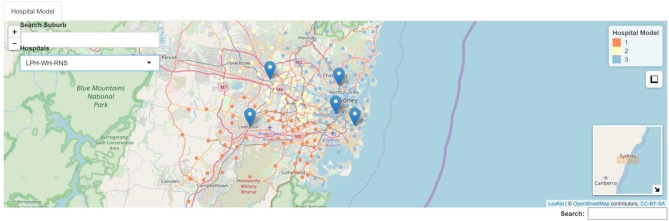
Example of 3 hospital model. RNS, Royal North Shore Hospital, light blue; LPH, Liverpool Hospital, orange; WH, Westmead Hospital, light yellow.